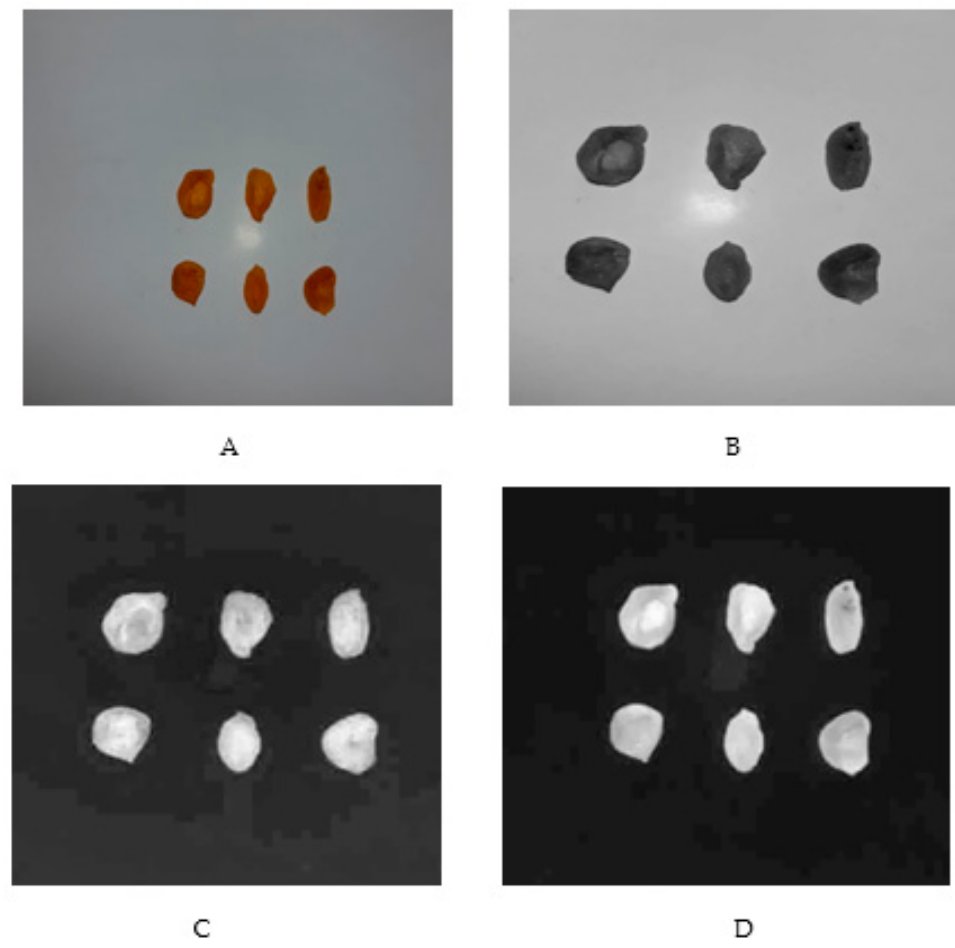
Figure 1. Image processing of the dried pieces of apricot: ( A ) RGB pictures taken with the digital camera; ( B ) Factor L* (brightness); ( C ) Factor a* (redness); ( D ) Factor b* (yellowness). In the images taken, the color parameters (L*, a*, and b*) were calculated for all pixels of the samples, and according to them, the mean values of each parameter were estimated (27.970, 23.119, and 36.397, respectively) through ImageJ 1.50 v software.